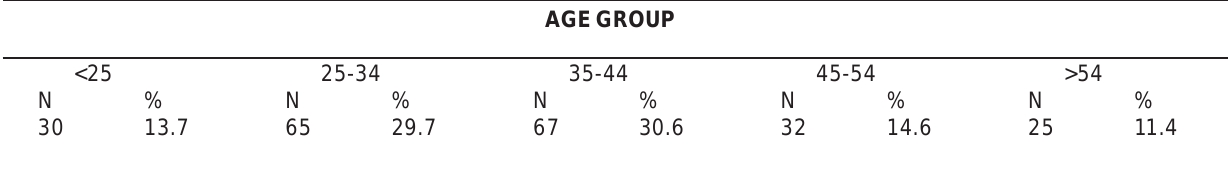
TABLE 1- Sample distribution according to age group. Bauru, Brazil,